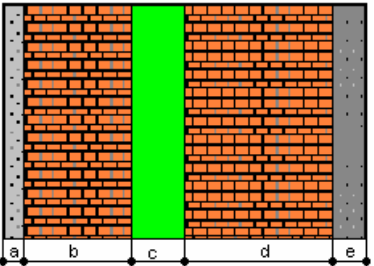
Figure 2. Sandwich wall model used for calculations (a. External plaster; b. Building material; c.